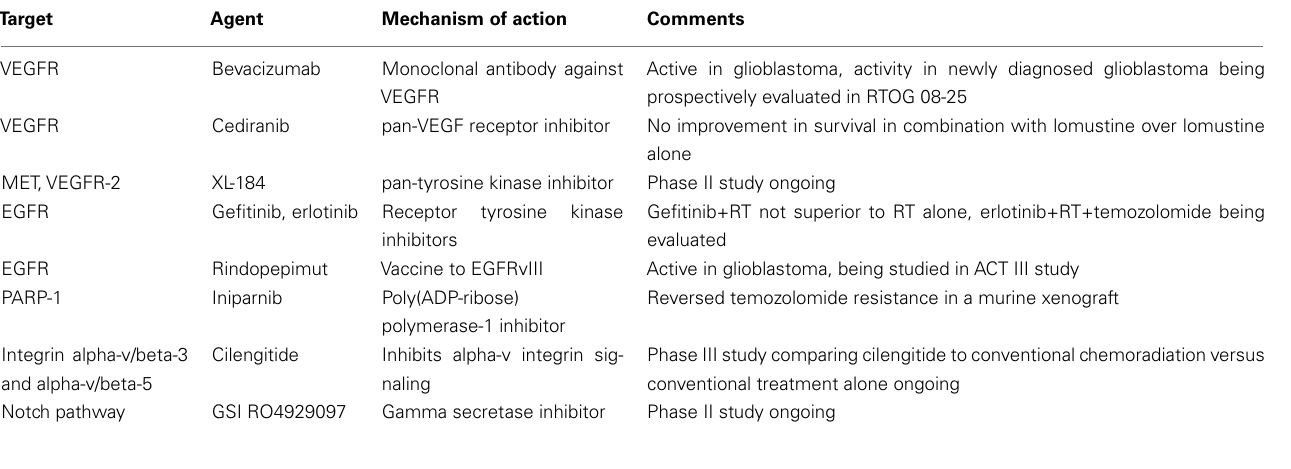
Table 4 | Novel targets and trials for